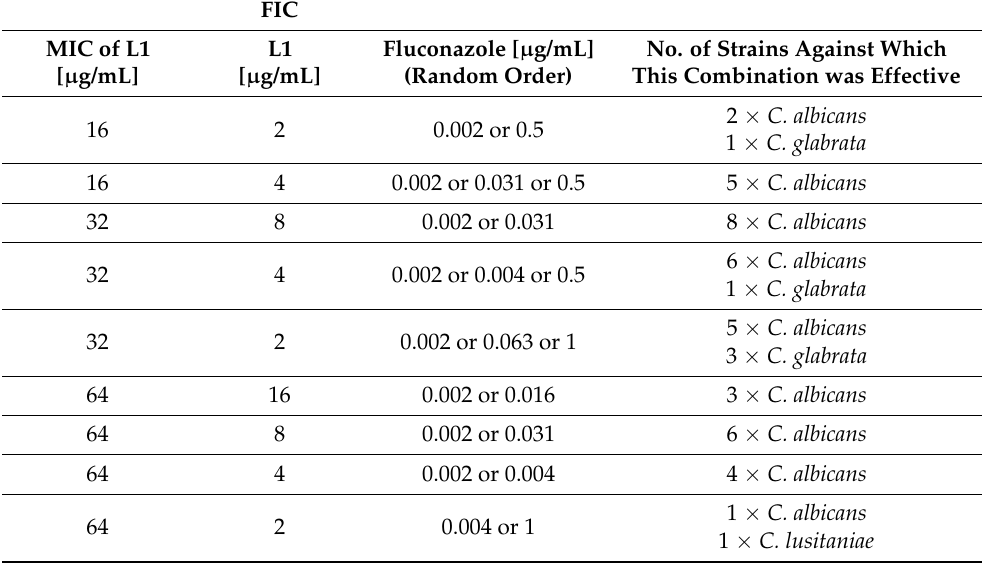
Table 2. Concentrations of fluconazole–L1 combination exhibited a synergistic effect against 46 isolates of Candida